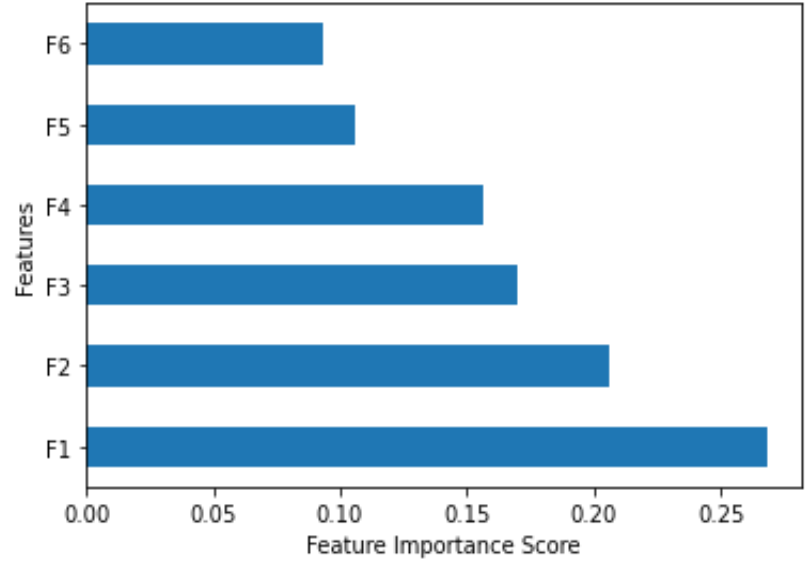
Figure 4. Feature importance score